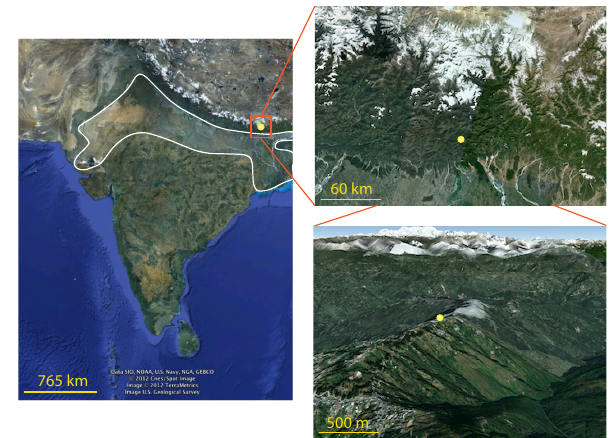
Fig. 1. Location of field site in Darjeeling, India (27 ◦ 02 0 N, 88 ◦ 15 0 E, 2194 ma.g.l., yellow dot) in the Himalayan foothills of Northeast India. The white border shows the approximate location of the Indo-Gangetic Plains of India. Images are from Google Earth.